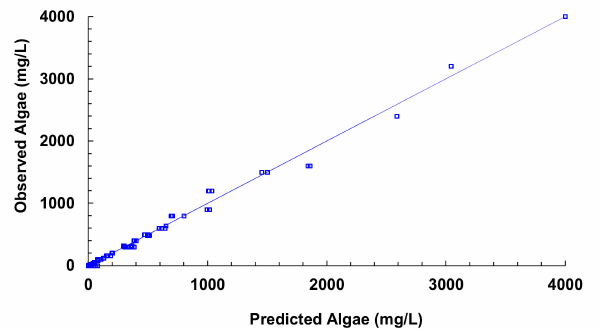
Figure 19. Observed vs. predicted values of algae concentration with different